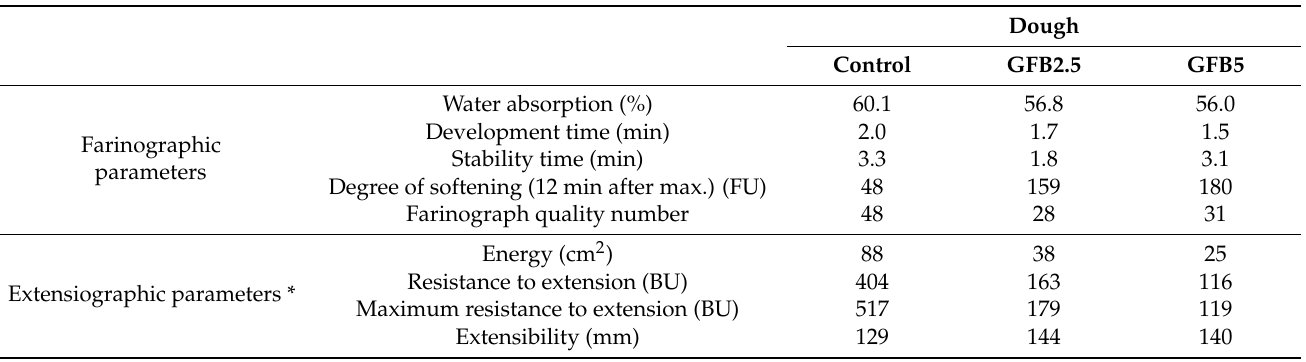
Table 1. Farinographic and extensiographic parameters of control (wheat) dough and wheat